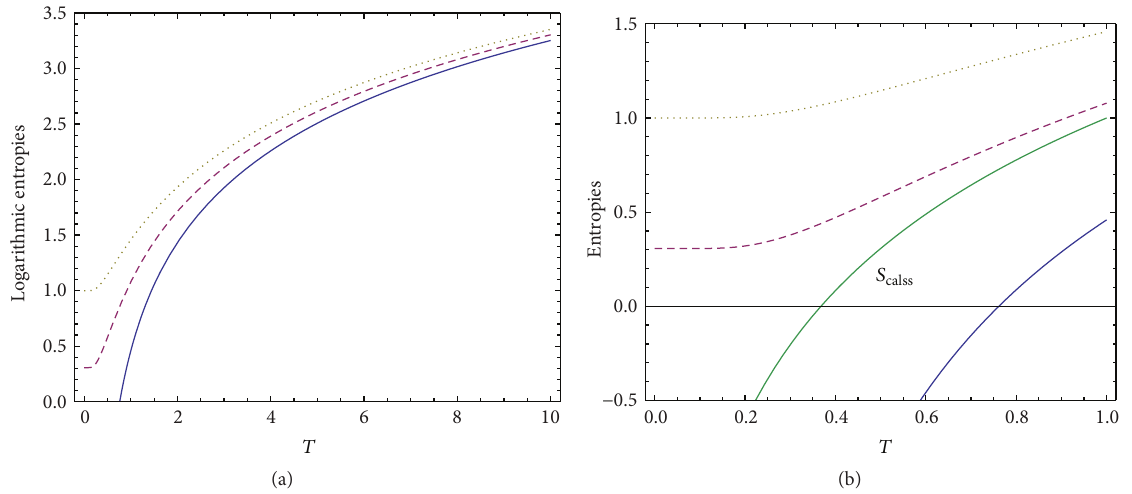
Figure 2: Left: logarithmic entropies, 𝑆 𝑃 , 𝑆 𝑄 , and 𝑆 𝑊 , as a function of the temperature 𝑇 in (ℏ𝜔/𝑘 𝐵 ) -units. The solid line is the case 𝑃 , the dashed one is the Wigner one, and the dotted curve is assigned to the Husimi instance. Right: zoom of the logarithmic entropies as a function of temperature 𝑇 in (ℏ𝜔/𝑘 𝐵 ) -units. Negative values of 𝑆 𝑃 occur below 𝑇 = ℏ𝜔/(𝑘 𝐵 ln (1 + 𝑒)) , with the critical temperature < 𝑇 details are similar to those of left figure. We have added the classical entropy of the harmonic oscillator 𝑆 class = 1 − ln (𝛽ℏ𝜔) .